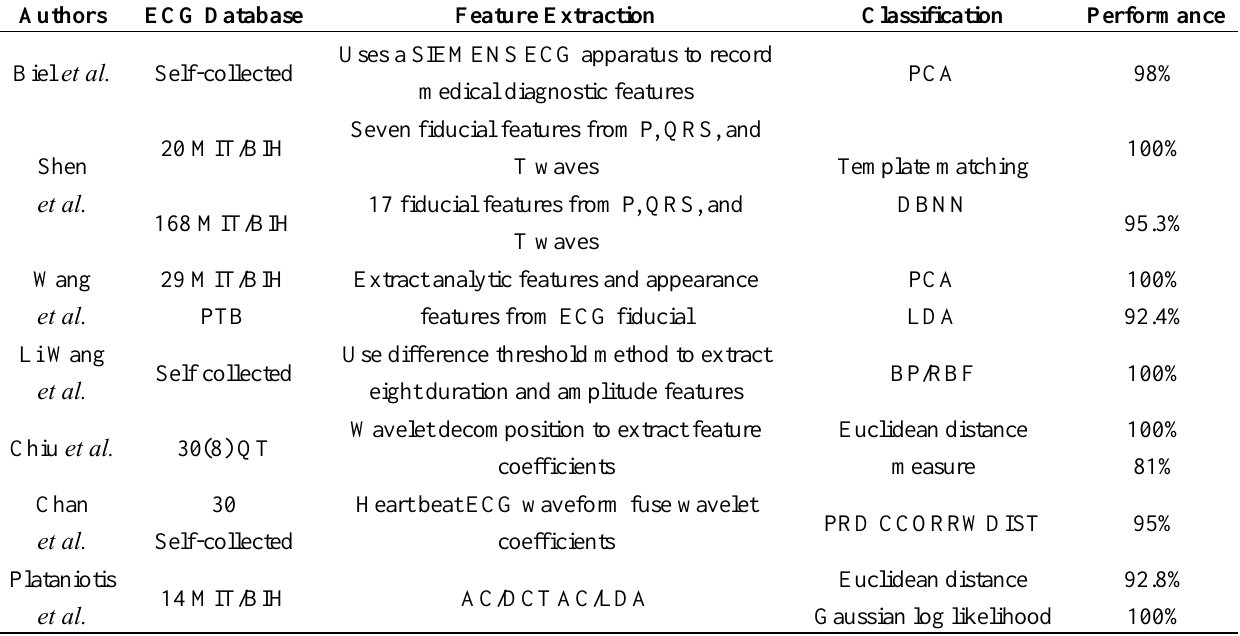
Table 1. Previously reported ECG analysis